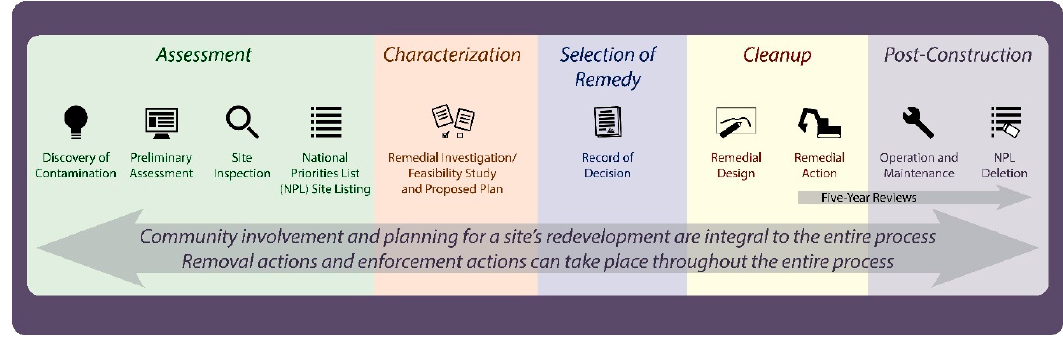
Figure 1. The Superfund Remedial Process.